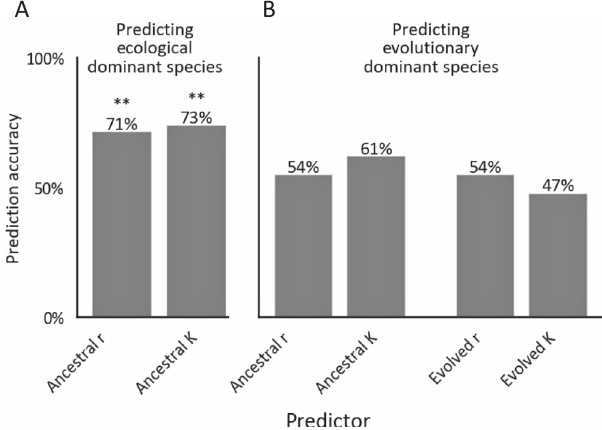
Fig. 5 Growth of strains that evolved in monoculture does not predict the dominant species in pairs. The accuracy of the prediction that the species with the higher growth rate (r)/carrying capacity (K) is more abundant in a pairwise competition at generation ~70 ( A ) and ~400 ( B ). Growth rate is measured as the time to a threshold of OD = 0.08 ( “ Methods ” ), and thus includes strains ’ lag time. An asterisks above bars indicate the probability to get a given level of accuracy by chance (one-sided binomial test, n = 42) ** = <0.001, for bars with no sign the probability is greater than 0.05. P values (from left to right): 0.003, 0.001, 0.32, 0.08, 0.32, 0.67. One species ’ growth (H77) was not measured and therefore the two communities that included it were removed from this analysis, and accuracies were evaluated from the data of 42 pairs. Source data are provided as a Source Data fi